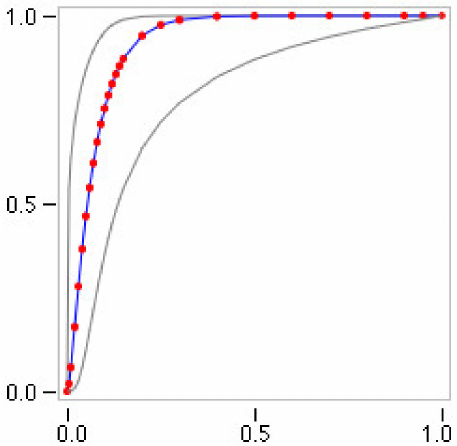
Figure 4. The ROC area of validation data: AUC (0.927).